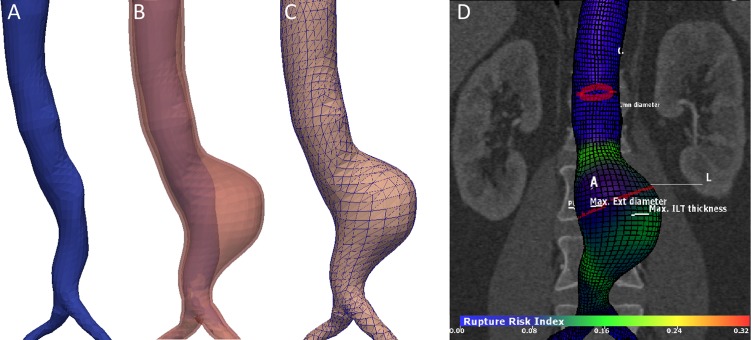
Workflow of the used software.A. Luminal segmentation in blue B. Luminal (blue) and thrombus (red) segmentation C. Exterior mesh. D. PWRI outcome displayed on the 3D model.